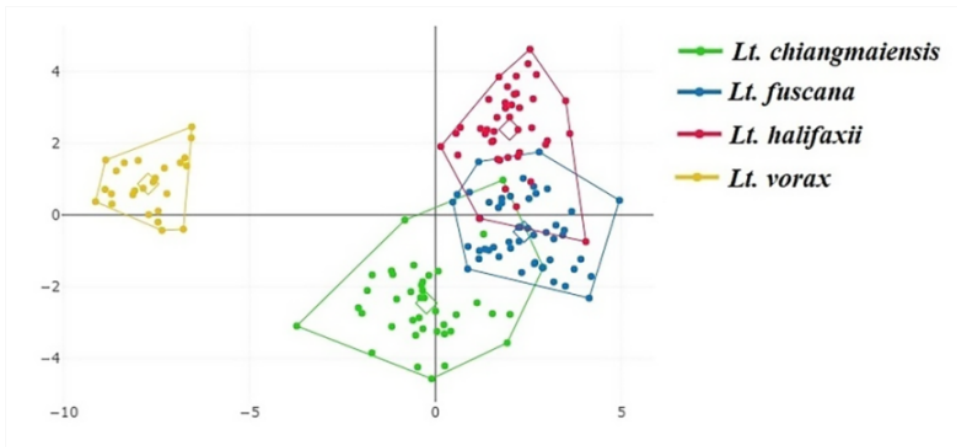
Figure 6. Discriminant space produced by the discriminant analysis of the wing shape of Lt. chiangmaiensis , Lt. fuscana , Lt. halifaxii , and Lt. vorax . Four Lutzia species’ wing shape variations are represented by each polygon, and each dot inside the polygons represents each individual sample. Table 2. Pairwise Mahalanobis distance and significant differences in the wing shape of Lt. chiangmaiensis , Lt. fuscana , Lt. halifaxii , and Lt. vorax.